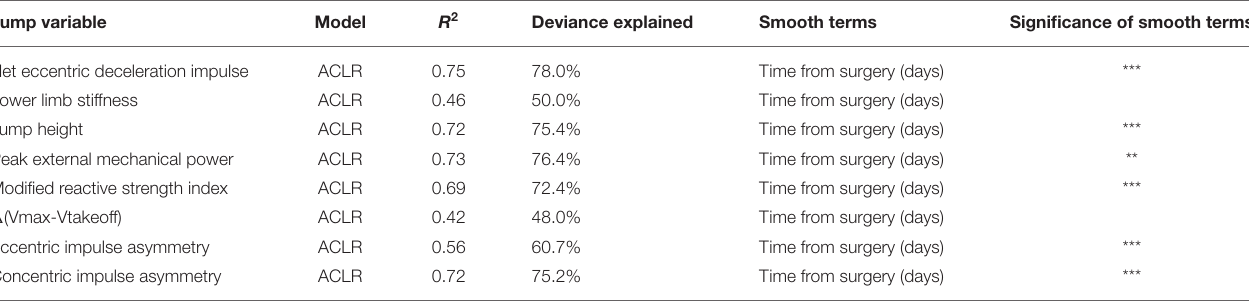
TABLE 3 | Model parameters for the anterior cruciate ligament reconstructed (ACLR) group vs. the time from